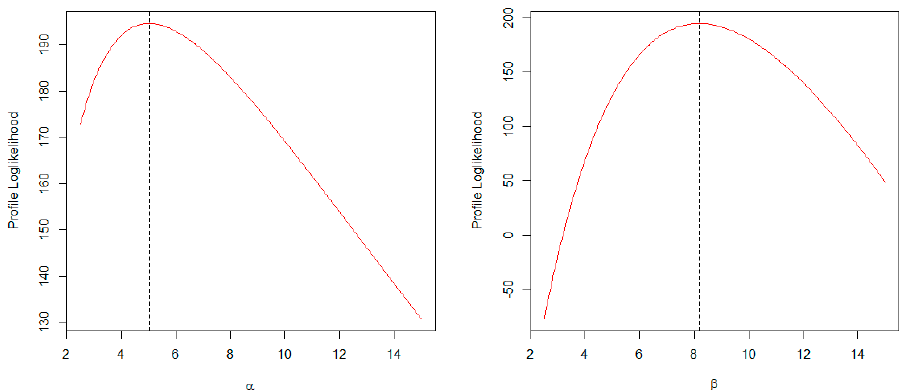
Figure 10. Profile log-likelihood plots of the estimated parameters of the AP distribution.